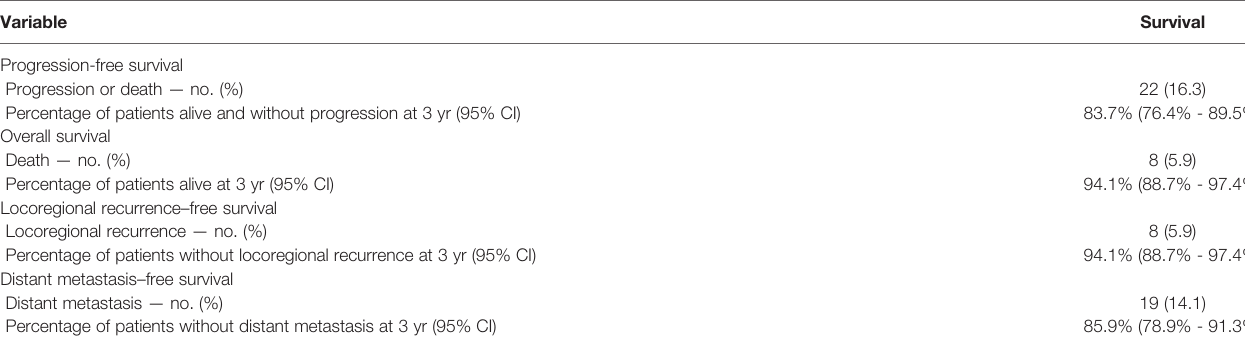
TABLE 3 | Survival to Treatment. Variable Survival Progression-free survival Progression or death — no.